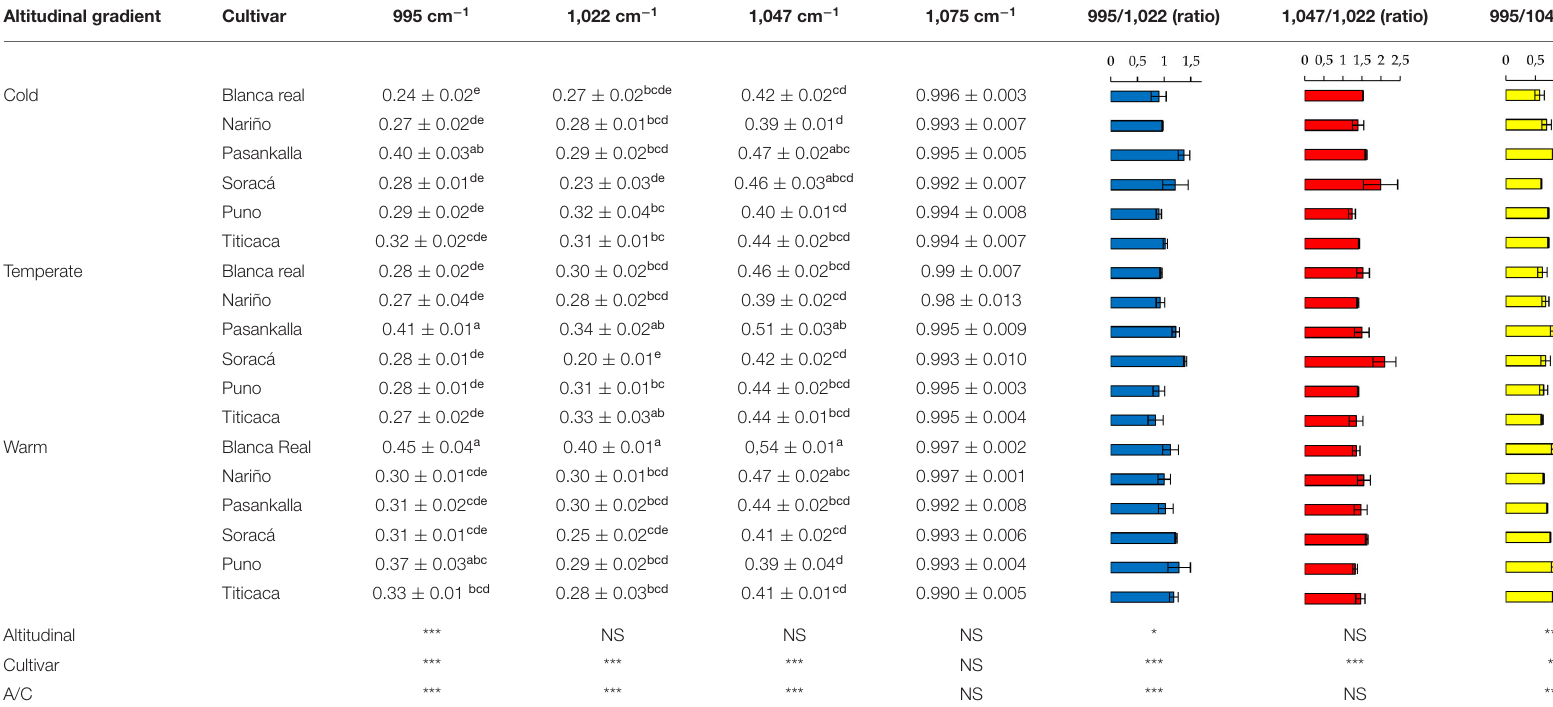
TABLE 4 | Intensity (a.u.) of Fourier transform infrared (FT-IR) spectra of starch region in different quinoa cultivars.